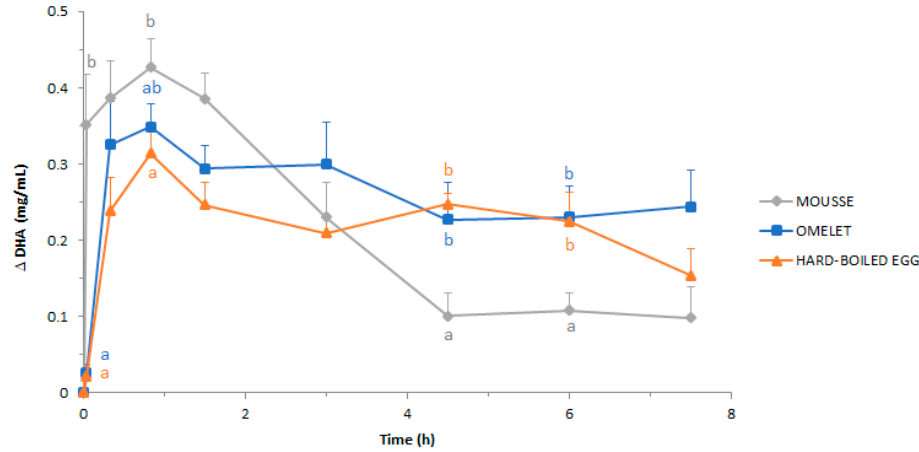
Figure 5. Base-line adjusted DHA concentration in the duodenal effluents throughout 7.5 h postprandial after the ingestion of the DHA-enriched omelet, hard-boiled egg, and mousse. Concentration is expressed as mg DHA/mL effluent. Means and SEM were calculated from n = 9 pigs. For a given digestion time, different letters display significantly different mean values ( p < 0.05).